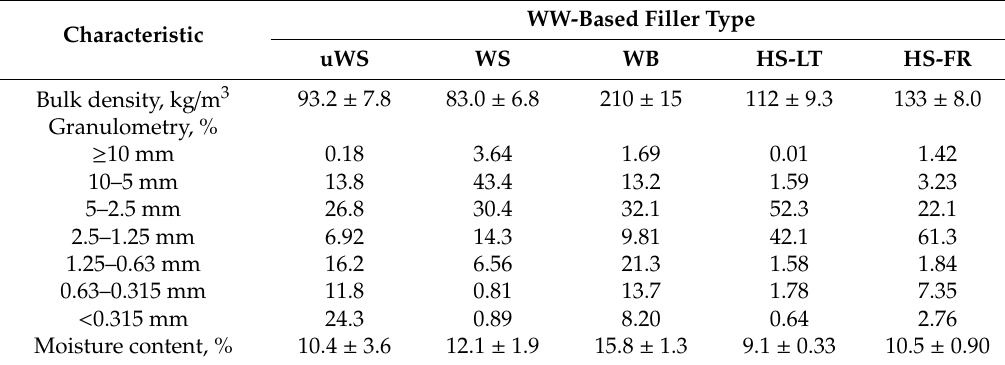
Table 1. The main physical characteristics of WW-based